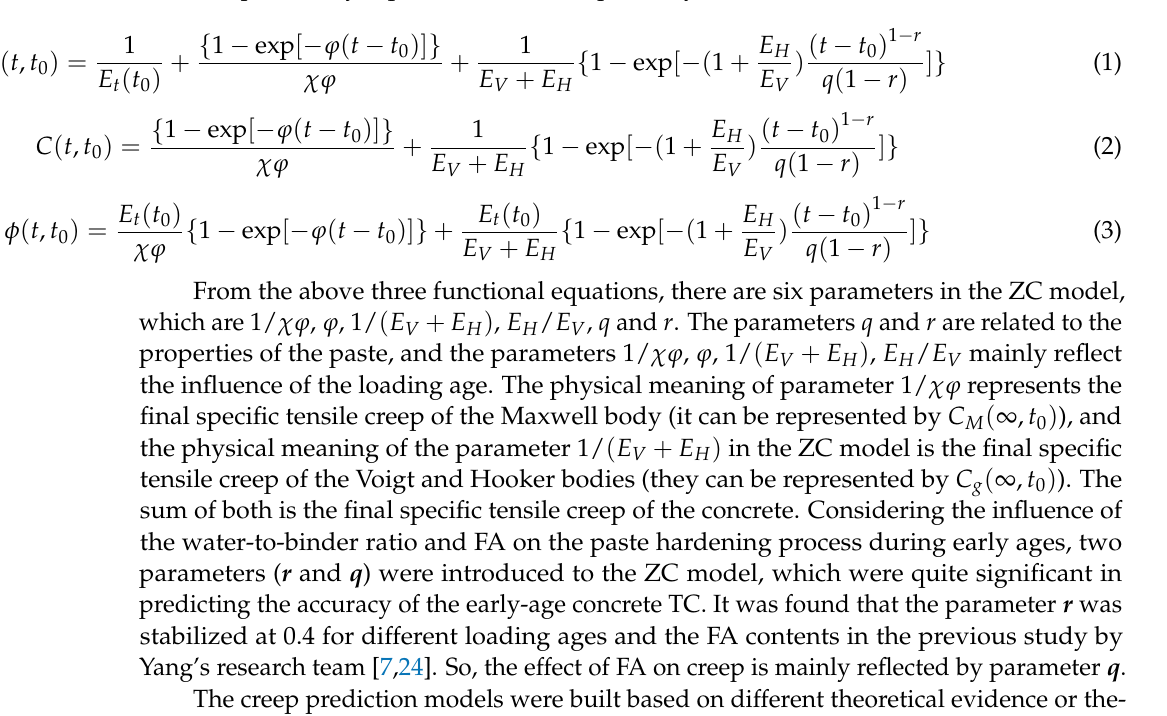
Figure 1. ZC rheological model of concrete creep. According to the ZC model, the creep compliance, specific creep, and creep coefficient can be expressed by Equations (1)–(3),